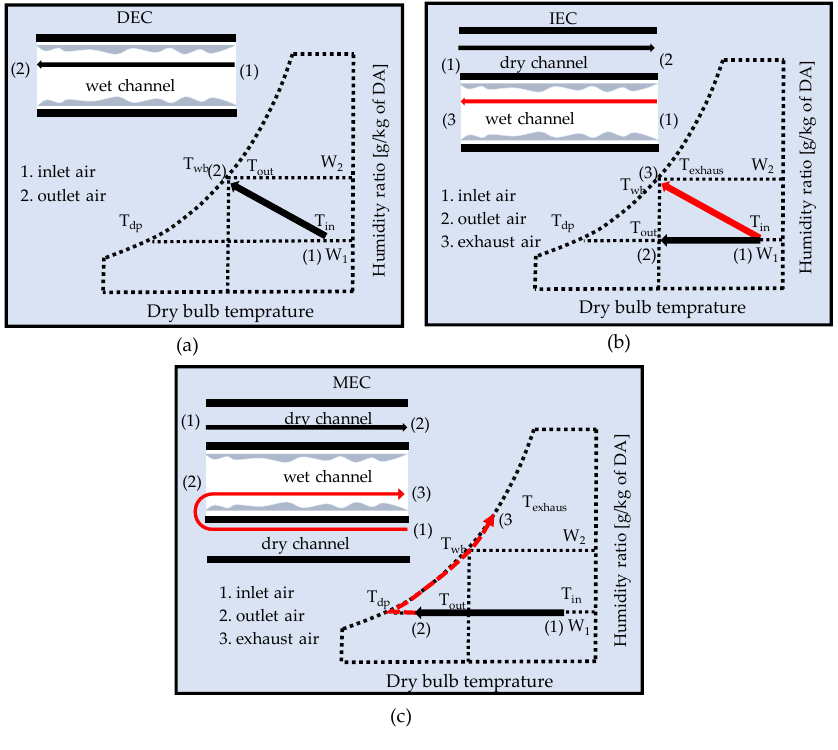
Figure 4. The schematic and psychrometric representations of the EC systems for ( a ) DEC, ( b ) IEC, and ( c ) MEC configurations.